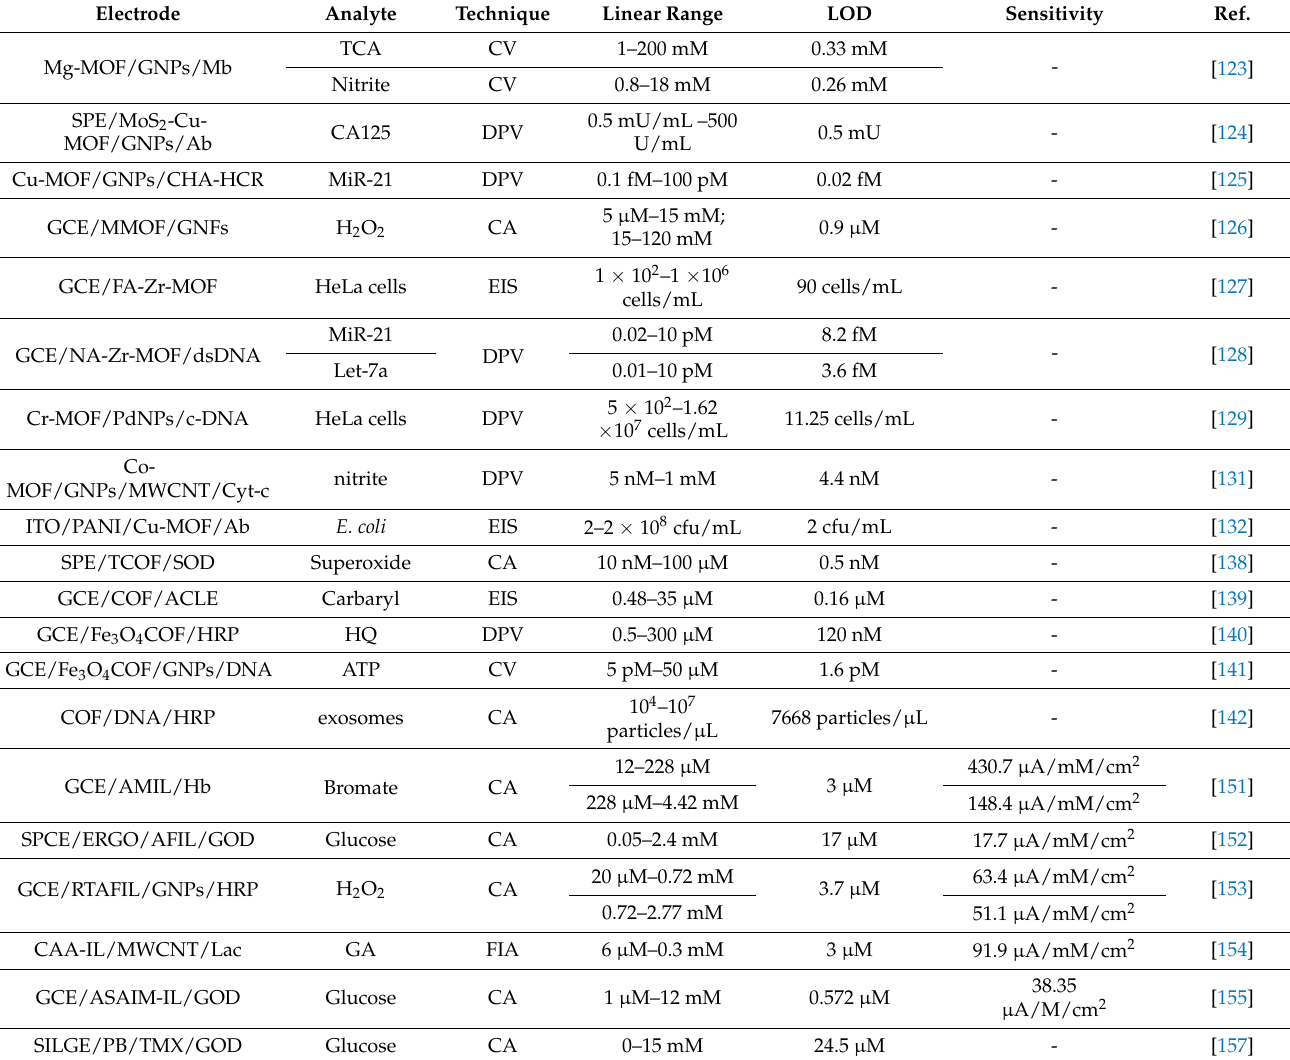
Table 2. Electrocatalytic performance of various functional molecules based electrochemical biosensors. Electrode Analyte Technique Linear Range LOD Sensitivity